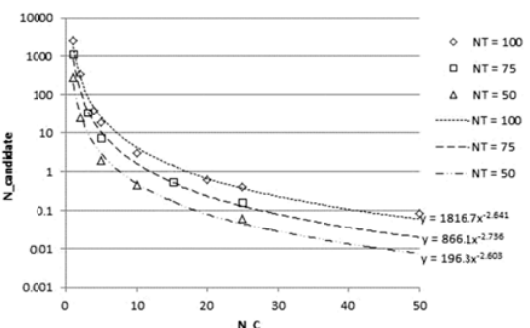
Fig. numb trans appro T be se aroun